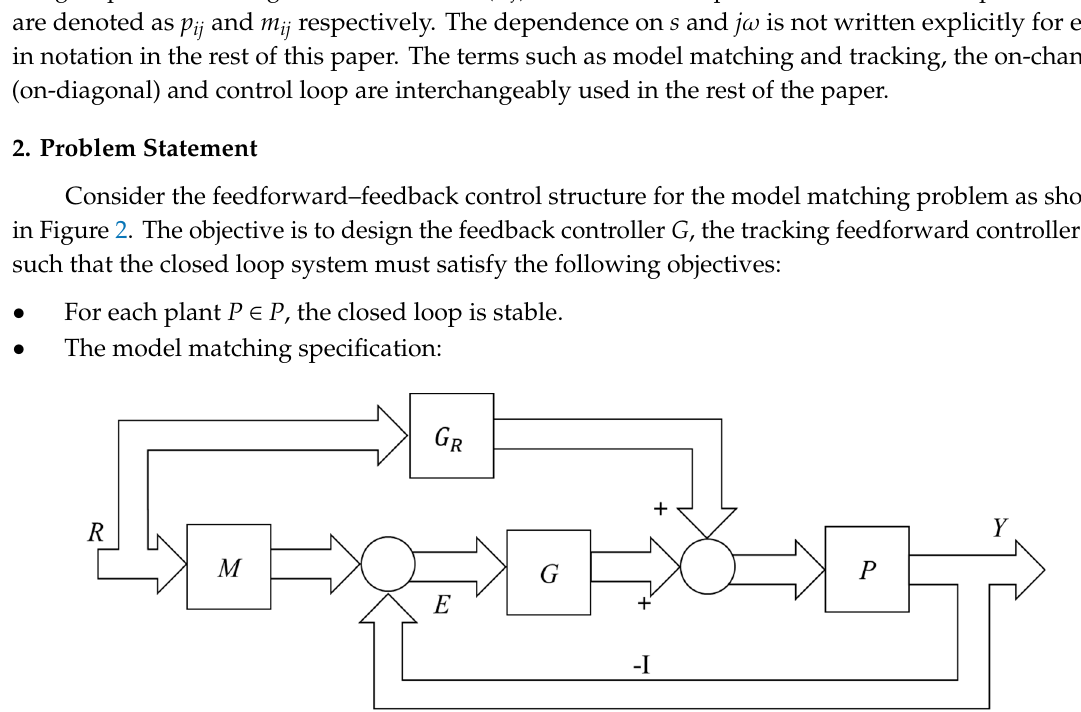
Figure 2. The 2-DOF feedforward-feedback control structure for the model matching problem in the MIMO control system.